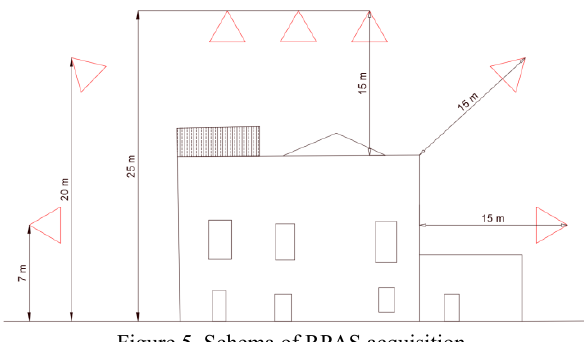
Figure 5. Schema of RPAS